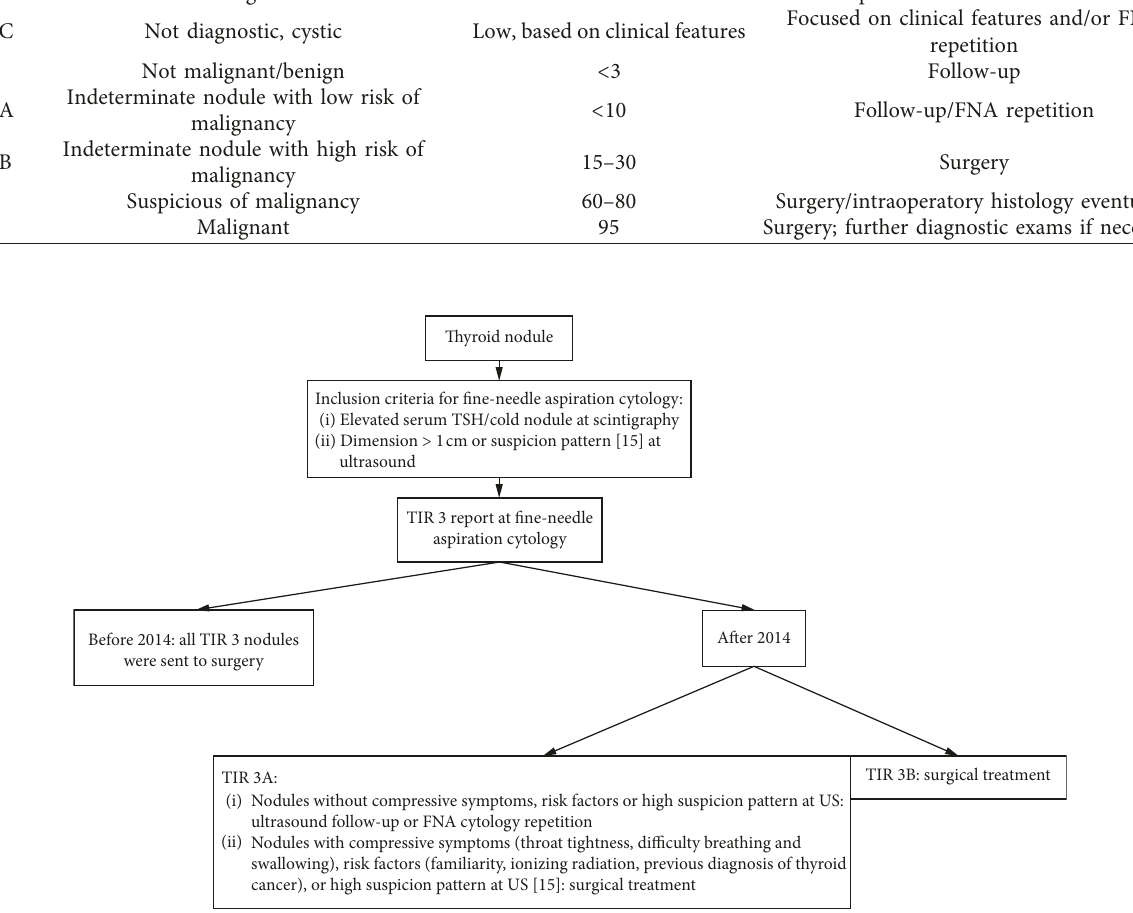
Figure 1: Flowchart: selection process of TIR 3